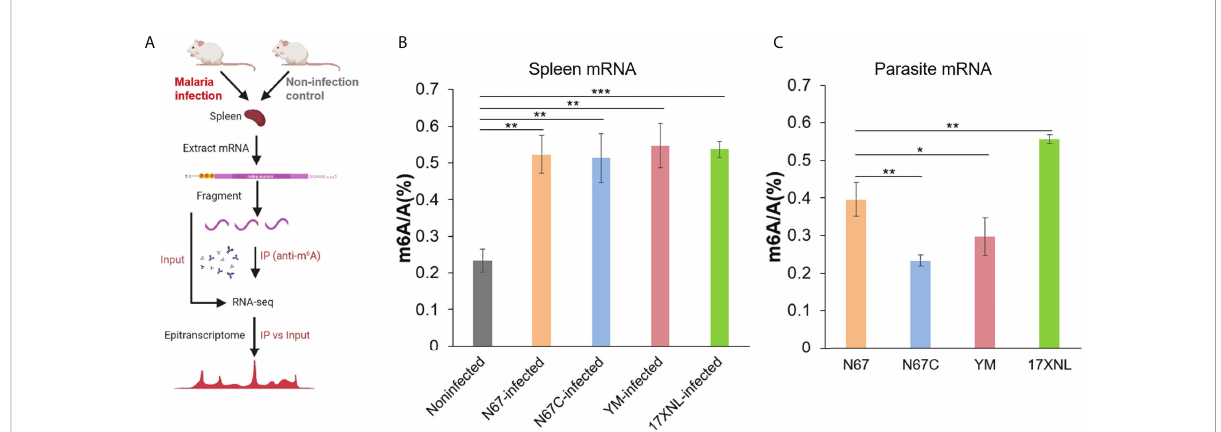
FIGURE 1 Malaria parasite infections in mice alter host spleen mRNA m 6 A methylation levels. (A) Schematic of the experimental design and MeRIP-seq protocol used in this study to identify differential m 6 A methylation pro fi les in mice spleens following infection with Plasmodium yoelii parasites. (B) LC-MS/MS quanti fi cation of m 6 A level in poly(A)-selected and RiboMinus-treated mRNAs isolated from the spleens of noninfected, P. y. nigeriensis N67-, P. y. nigeriensis N67C-, P. y. yoelii YM-, or P. y. yoelii 17XNL- infected mice. (C) LC-MS/MS quanti fi cation of m 6 A level in poly (A)-selected and RiboMinus-treated mRNAs isolated from N67, N67C, YM and 17XNL parasites. Values are the means ± SD, n=3. *P < 0.05; **P < 0.01; ***P < 0.001, Student ’ s t test.